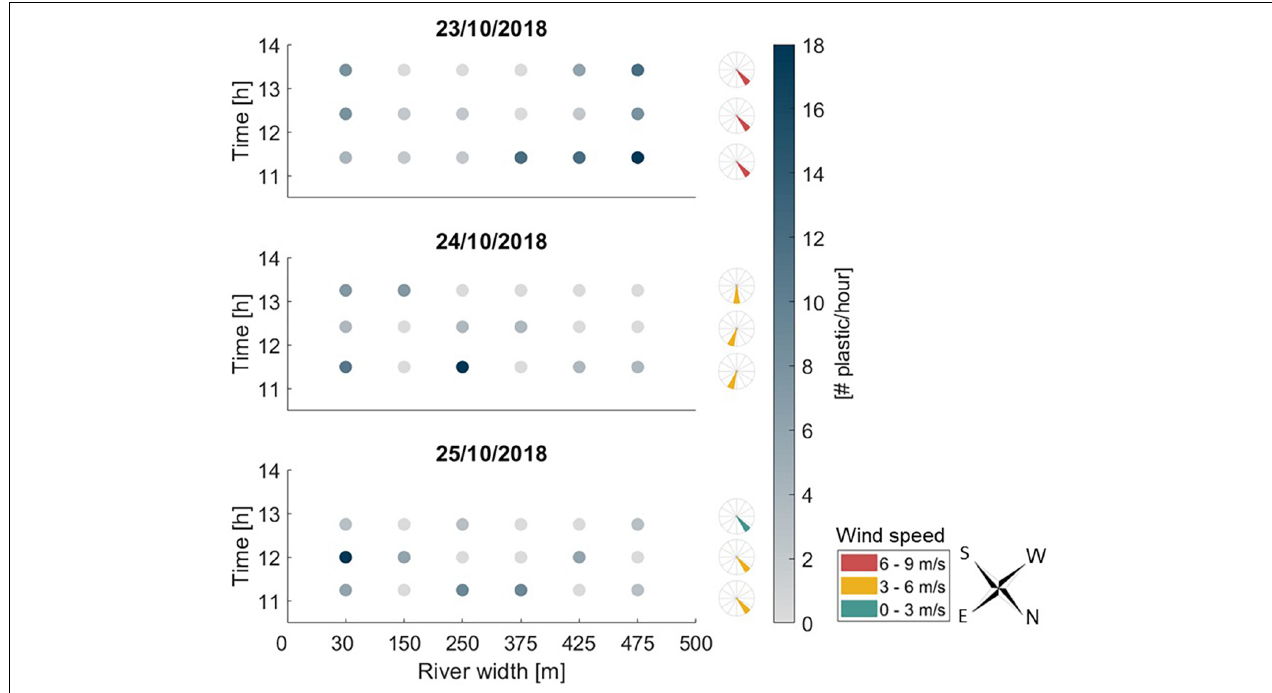
FIGURE 2 | Plastic concentrations in the river Rhine, with the concentration distribution over the river width (blue dots), the wind direction (with the wind direction oriented according to compass given) and wind velocity in m/s, all for 3 days, three time points per day.